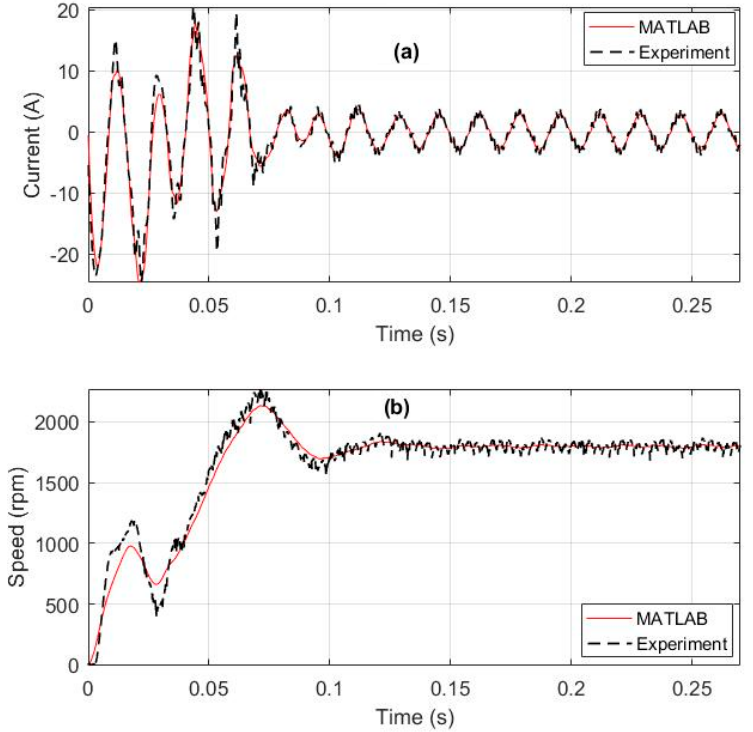
Figure 21. LSPMSM under 4 N·m load ( a ) Stator phase A Current ( b ) speed.